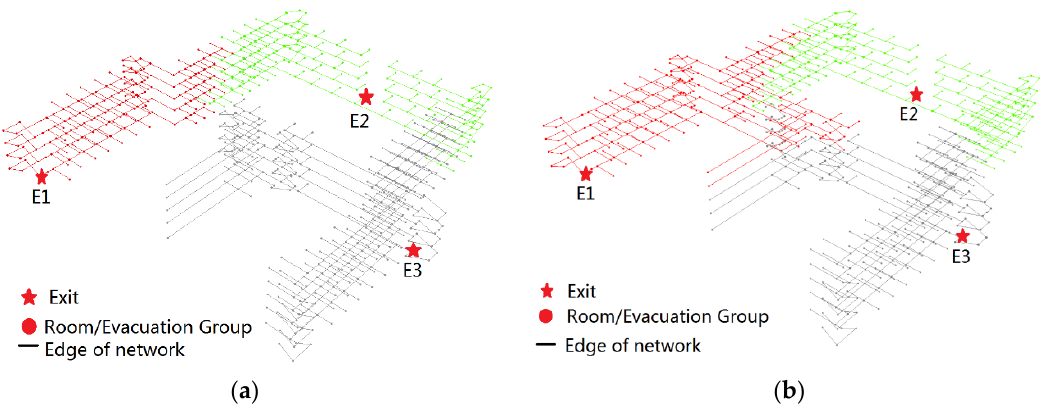
Figure 12. Comparison of results partitioned by two different partitioning methods. ( a ) The partitioned network based on nearest evacuation; ( b ) The partitioned network based on balanced evacuation